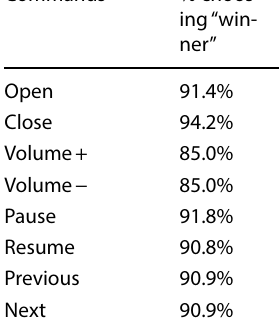
Table 5 The result of 8 frequently used media referents from participants’ acceptability